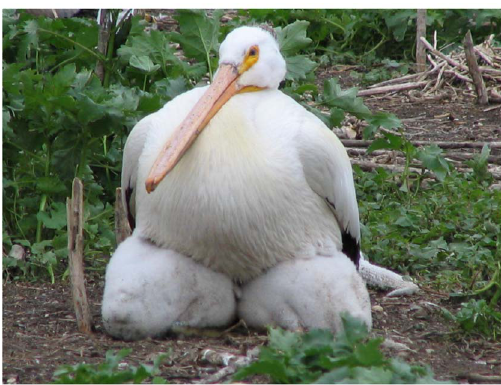
Figure 1. Two older American white pelican chicks (5–6 weeks old) returned to their nest to be brooded during inclement weather (10 June 2006, Chase Lake, North Dakota), but were too large to be covered by the parent. Both chicks later died.